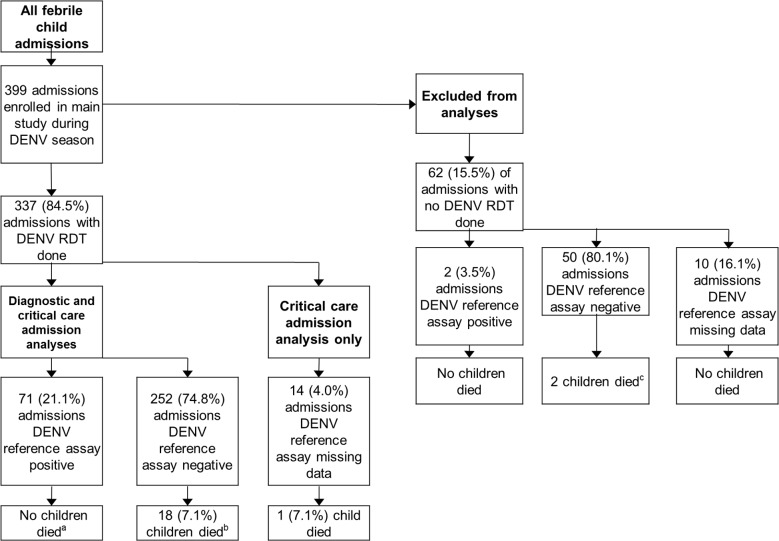
Flowchart depicting enrollment, DENV reference assay results, and outcome of patients into this study of a DENV RDT from the main prospective study of cause of fever in the cohort [20].